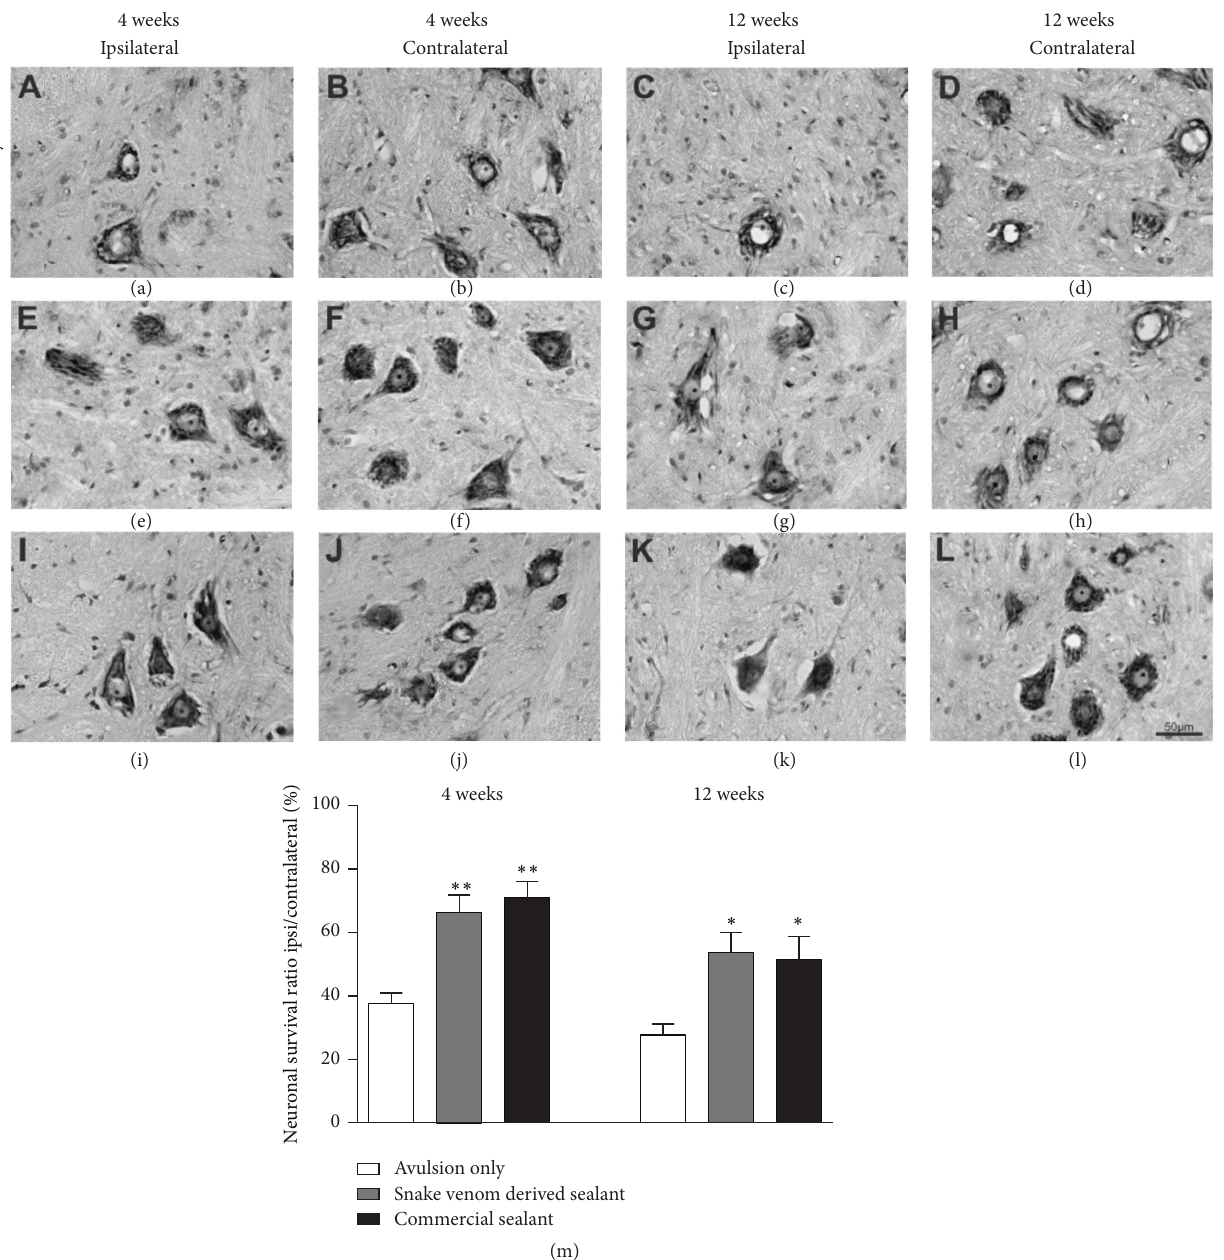
Figure 1: Nissl-stained spinal cord transverse sections at lamina IX illustrating the neuroprotective effect of root reimplantation on motoneurons, 4 and 12 weeks following ventral root avulsion and repair. Note the decreased number of motoneurons, ipsilateral to the lesion. Also, observe the improvement of neuronal survival in the reimplanted groups. (a-b, e-f, and i-j) Ipsilateral and contralateral sides, 4 weeks after lesion. (c-d, g-h, and k-l) Ipsilateral and contralateral sides, 12 weeks after lesion. (m) Percentage of neuronal survival 4 and 12 weeks following ventral root avulsion and reimplantation. The reimplanted groups displayed a significantly increased neuronal survival, 4 and 12 weeks after lesion. Scale bar = 50 𝜇 m. Mean ± SE. ∗ 𝑝 < 0.05 ; ∗∗ 𝑝 < 0.01